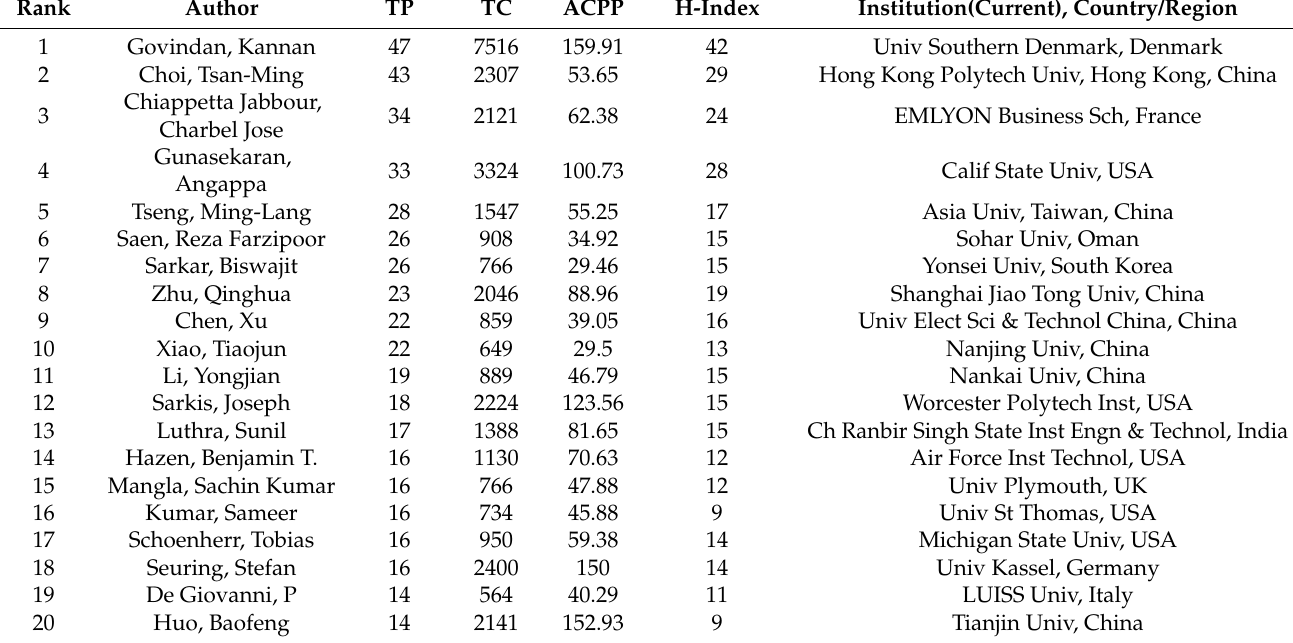
Table 6. Contribution of the top 20 corresponding authors in